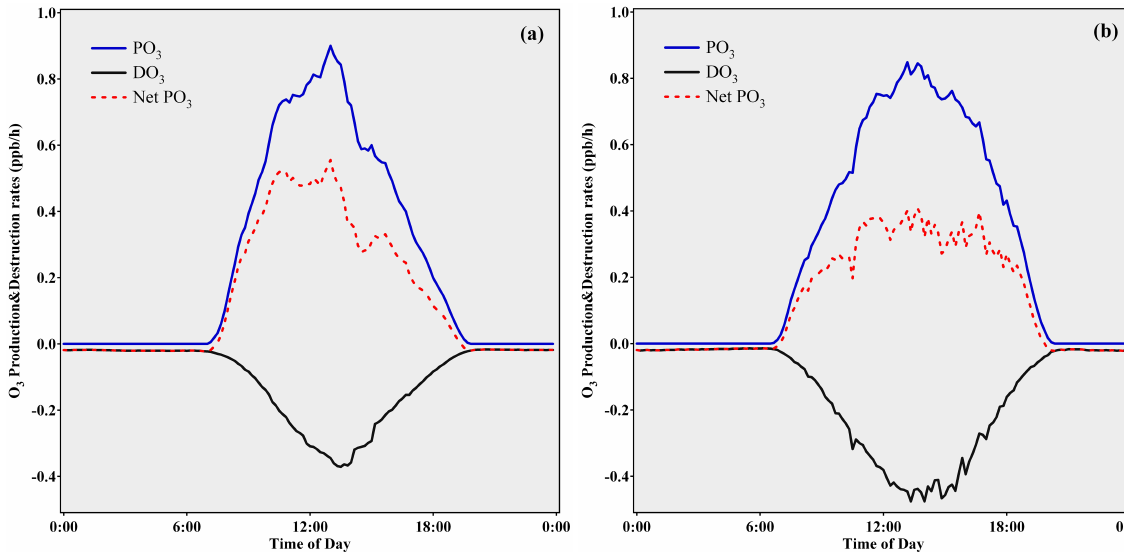
Fig. 4. Modeled O 3 in situ production, destruction, and net rates at WLG in (a) spring and (b) summer.